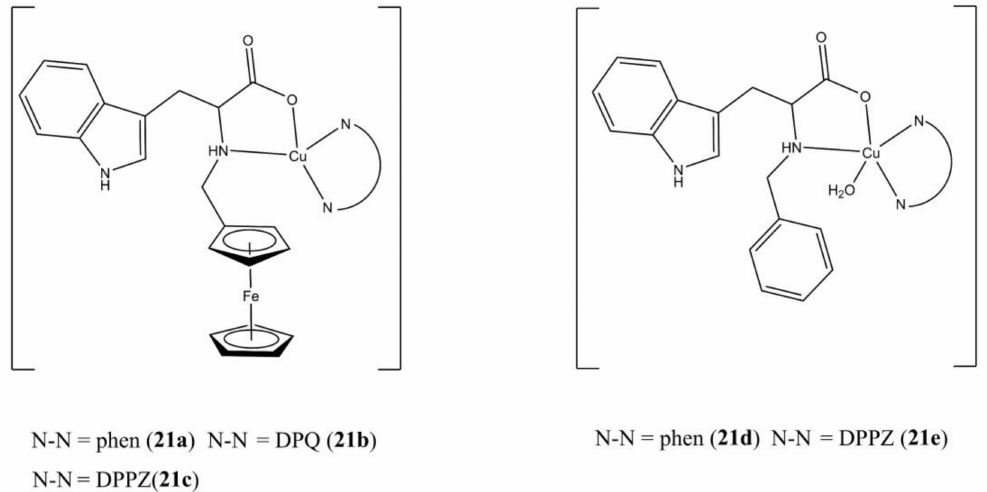
Figure 21. Structures of the phenanthroline-based [Cu(Fc-Trp)(N-N 5 )](ClO 4 ) ( a – c ) and [Cu(Ph-Trp)(N- N 5 )(OH 2 )](ClO 4 ) ( d , e ) complexes.